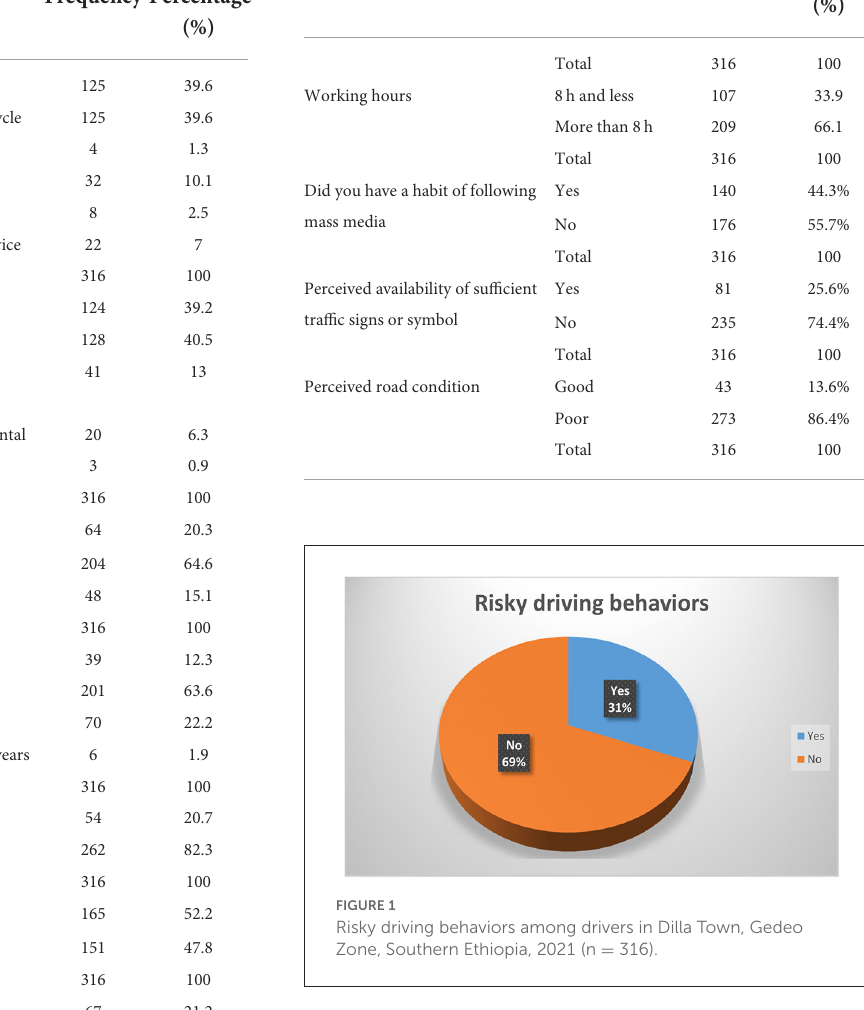
finding is not consistent with the study conducted among motorcycle taxi drivers in 32 regions of Caicó; the Rio Grande do Norte, Brazil, which found that 63.6% of them were involved in at least one motorcycle accident (17). In Southern Nigeria, (87.5%) of commercial motorcyclists were involved in road traffic accidents the year before the study (21). In Ghana, 74.0% were reported to have been involved in crashes in the past year before the study (20). A systematic review, GIS, and meta- analysis study in Iran showed that the prevalence of road traffic accidents was 51.50% (19), and a study was conducted in Adama (54.7%) (29). Moreover, it is not consistent with a hospital-based study conducted in Wolaita Zone, SNNPR, Ethiopia, in which 62.5% of trauma victims were due to road traffic accidents